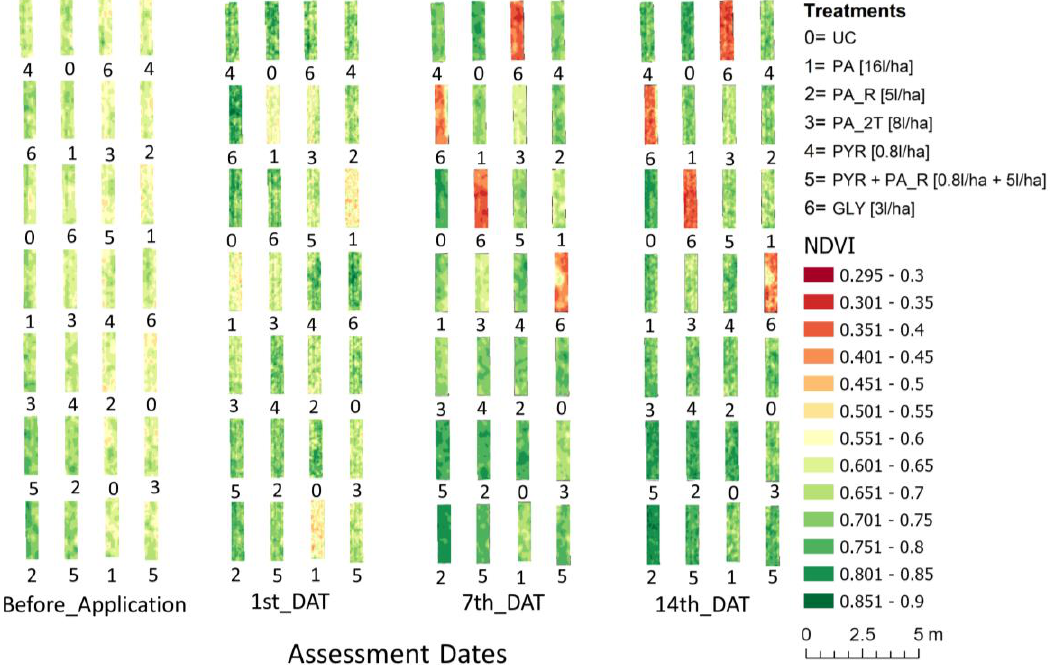
Figure 7. Changes in plant vitality due to different herbicides during the experiment in 2021, ex- pressed by NDVI.